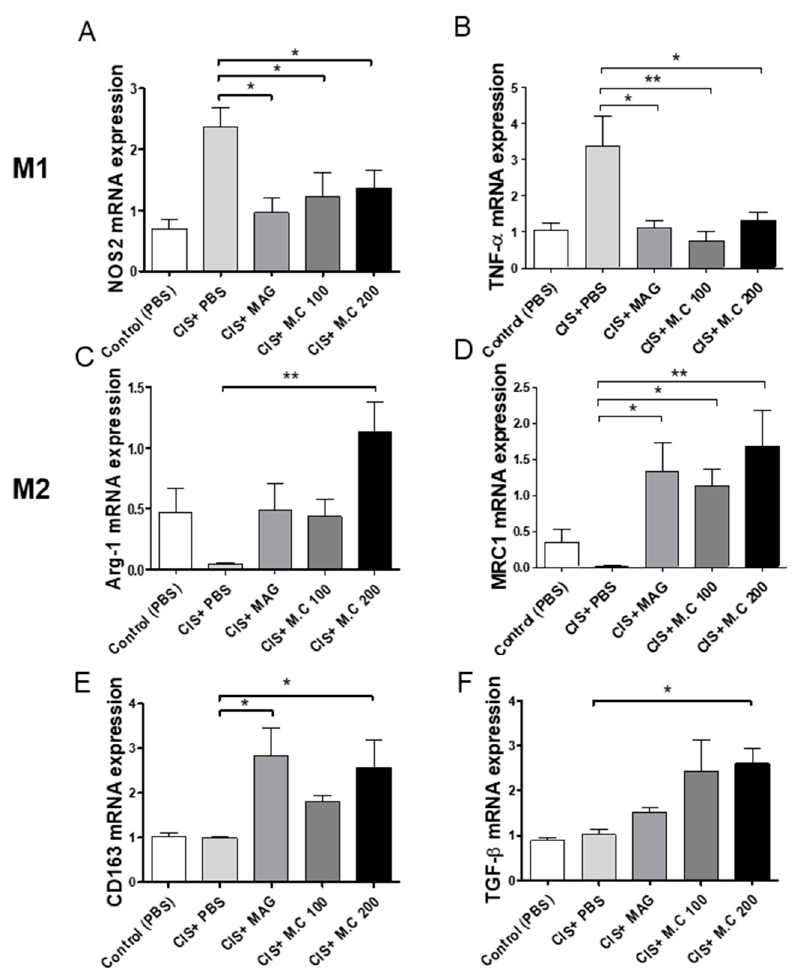
Figure 4. M.C modulated M1 and M2 macrophage polarization in skeletal muscle. The mRNA expression of M1- and M2-specific genes was assessed by qPCR: ( A ) NOS2; ( B ) TNF- α ; ( C ) Arg-1; ( D ) MRC1; ( E ) CD163; and ( F ) TGF- β . M1 macrophage makers ( A , B ), and M2 macrophage makers ( C – F ). Data are presented as the mean ± SEM ( n = 4~5/group). * p < 0.05, ** p < 0.01 vs. CIS+PBS, using a Bonferroni post hoc test after one-way ANOVA.